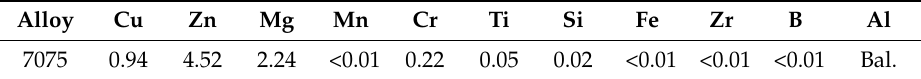
Table 1. Chemical composition of wrought 7075 Al alloy (mass %) used in this study [2].